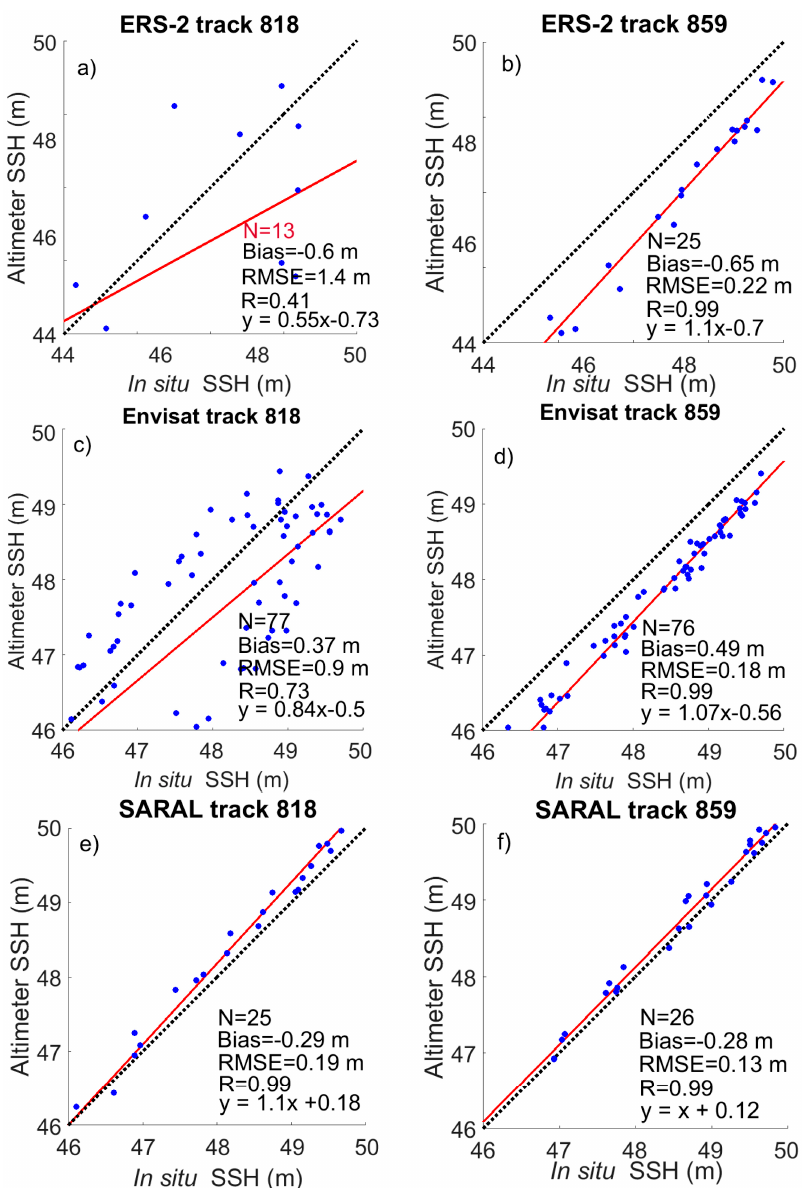
Figure 4. Comparisons between in situ and altimeter-based sea level anomalies in La Rochelle for ( a , b ) ERS-2; ( c , d ) Envisat; and ( e , f ) SARAL for descending track 0818 and ascending track 0859. The ionosphere and wet troposphere corrections were derived from GIM and ECMWF models,